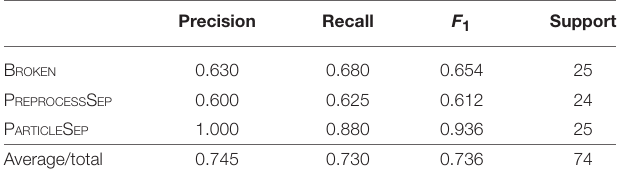
TABLE 2 | Performance metrics for the classifier based on the hand-labeled test data. Precision Recall F